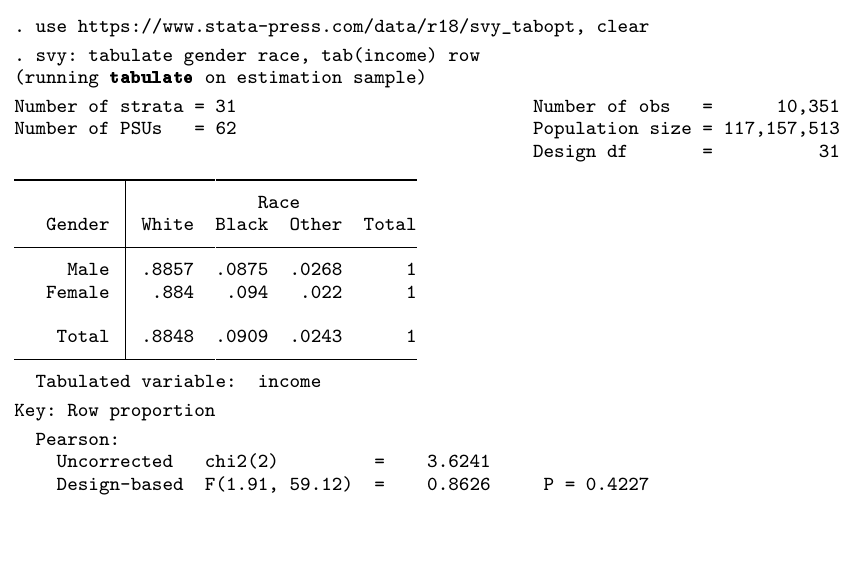
svy: tabulate twoway — Two-way tables for survey data